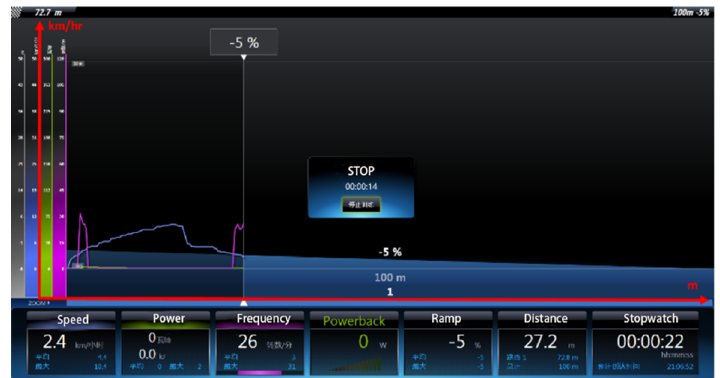
Figure 19. Results for road slope − 5%, cyclist weight 40 kg, and electromagnetic reversal braking.